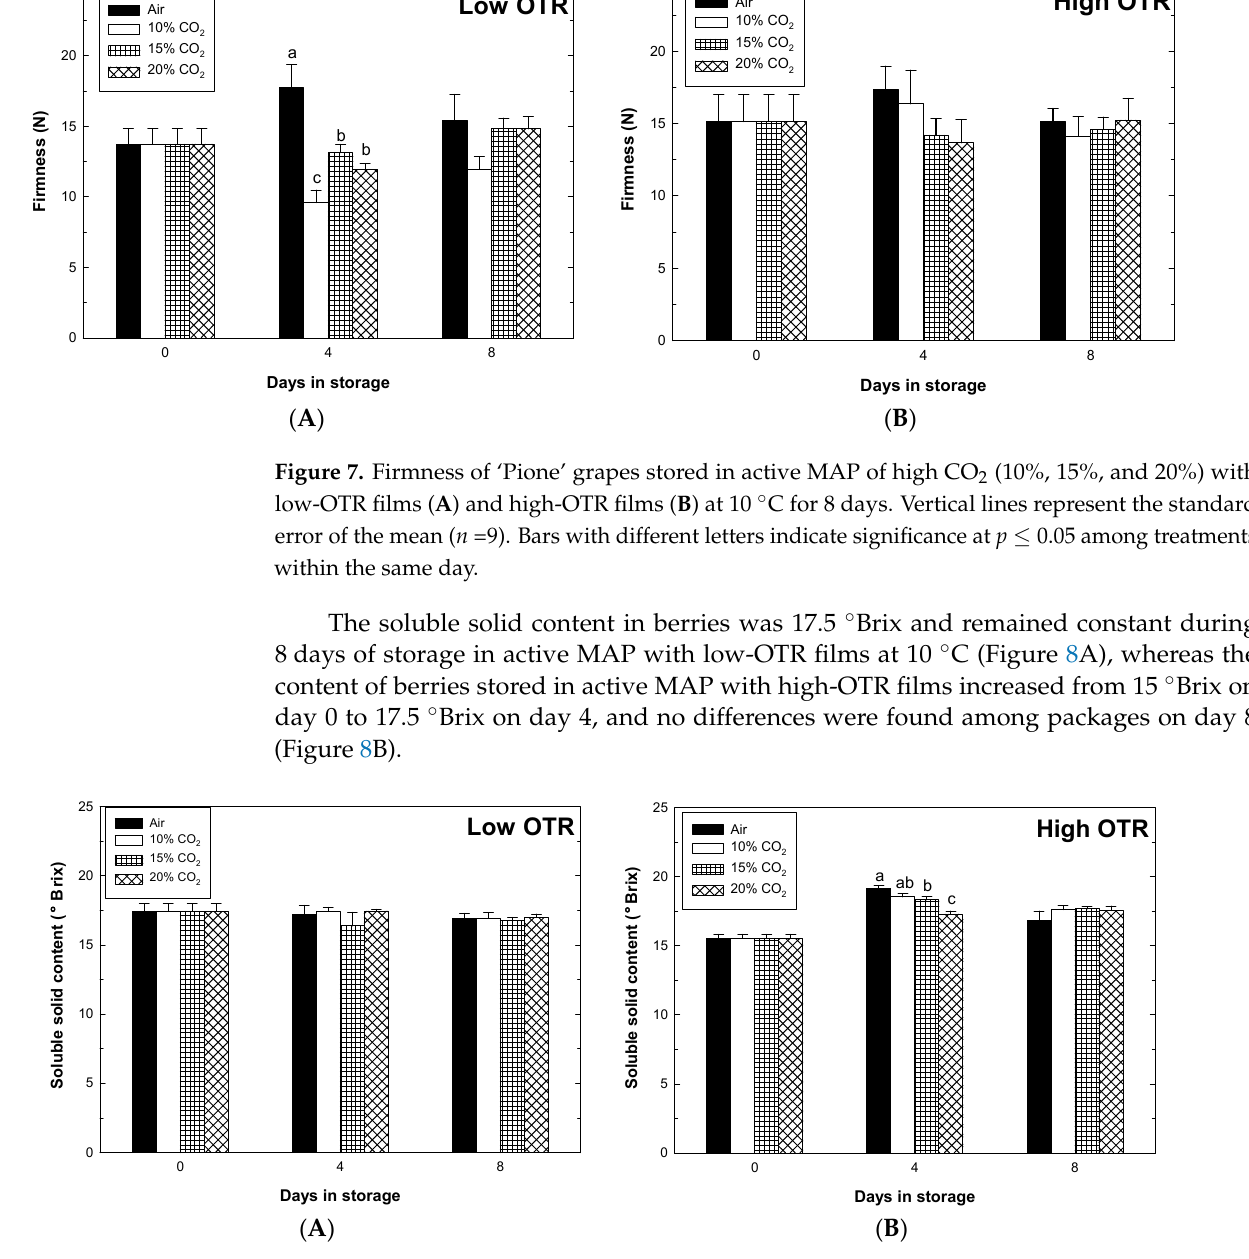
Figure 8. Soluble solid content of ‘Pione’ grapes stored in active MAP of high CO 2 (10%, 15%, and 20%) with low-OTR films ( A ) and high-OTR films ( B ) at 10 °C for 8 days. Vertical lines represent the standard error of the mean ( n = 9). Bars with different letters indicate significance at p ≤ 0.05 among treatments within the same day